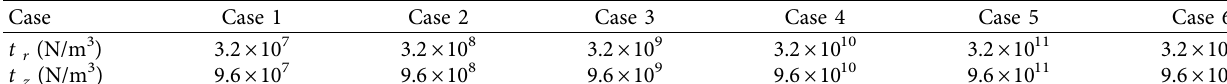
z and t r ) of the six cases.